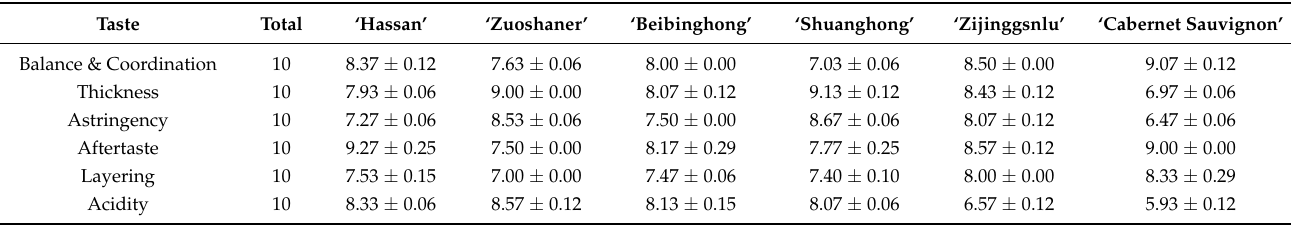
Table 4. Sensory evaluation of different varieties of